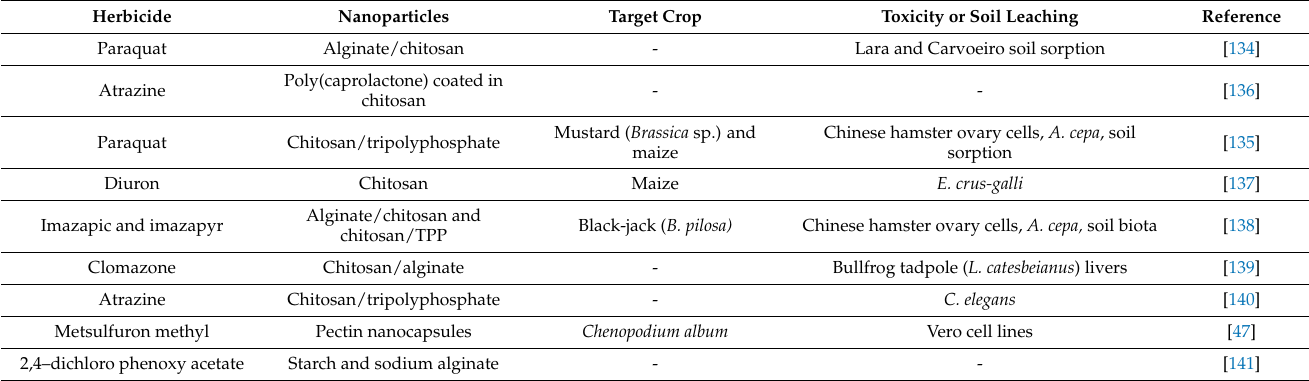
Table 4. Biopolymeric nanoparticles assessed as carriers of